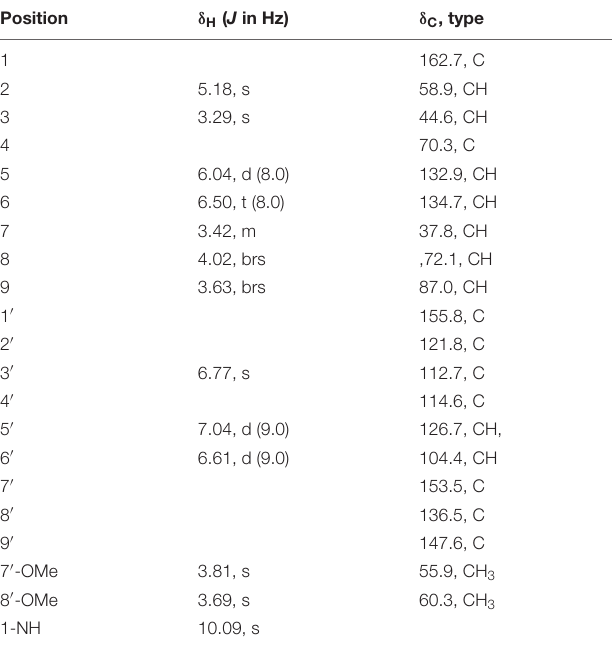
TABLE 1 | 1 H NMR data (500 MHz, DMSO- d 6 , δ in ppm, J in Hz) and 13 C NMR data (125 MHz, DMSO- d 6 , δ in ppm) for 1 .